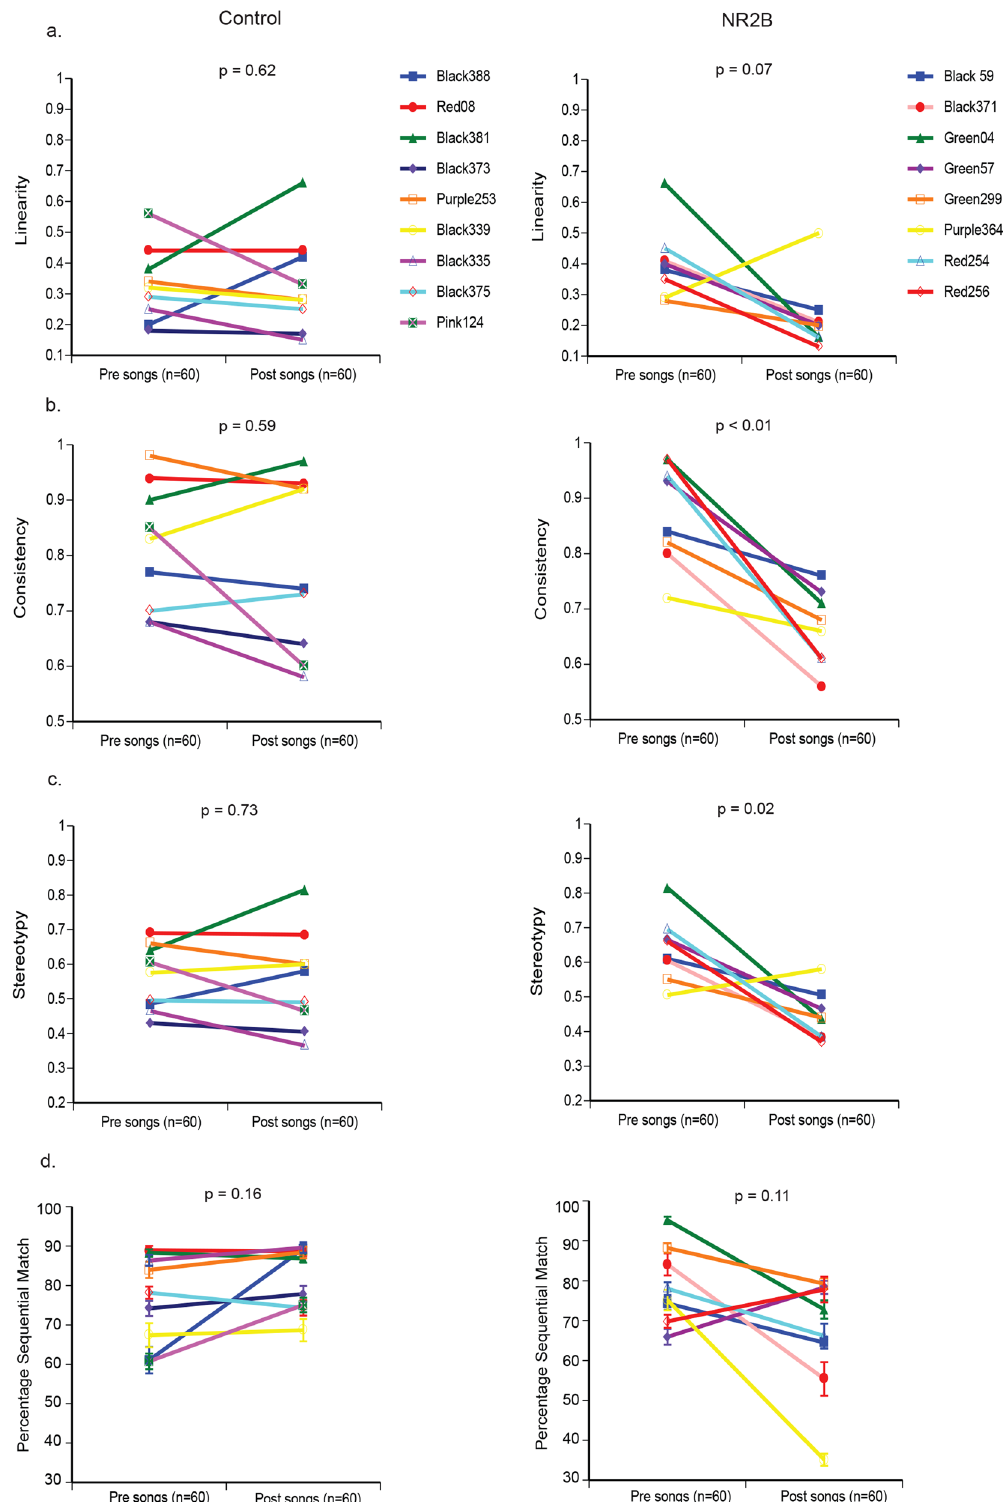
Figure 6. Song sequencing changes after overexpression of human NR2B in LMAN. ( a ) Song motif linearity. ( b ) Song motif consistency. ( c ) Song motif stereotypy. ( d ) Percentage sequential match. Each line is one animal presurgery and postsurgery, mean ± SE, with p values determined using paired Wilcoxon signed-rank